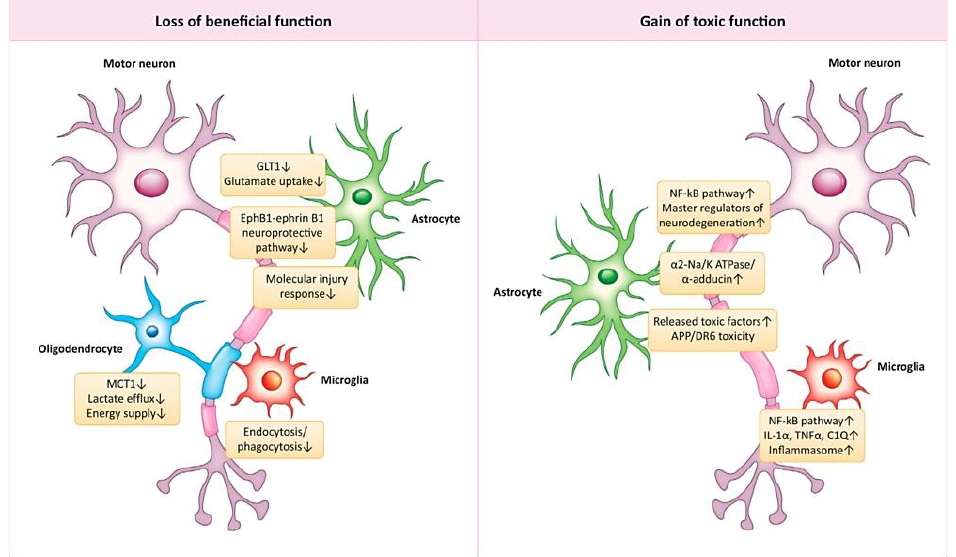
Figure 6. Illustration of the non-cell autonomously based pathogenesis of ALS. This published